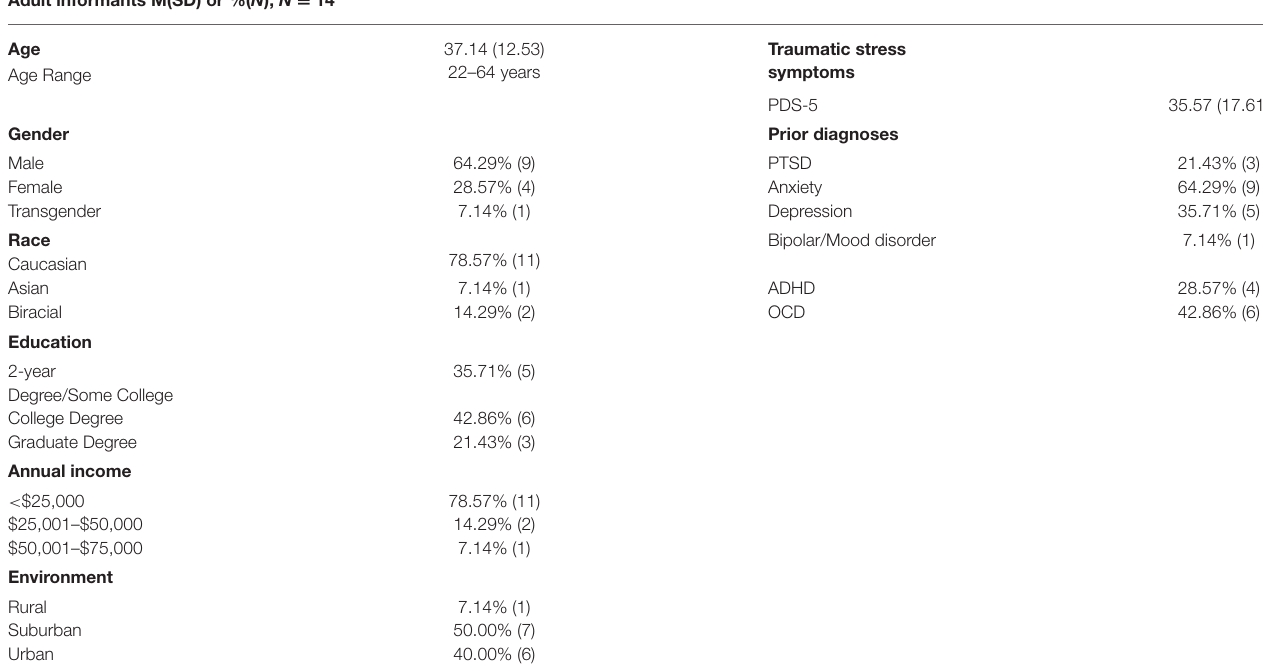
TABLE 1 | Characteristics of autistic adults.